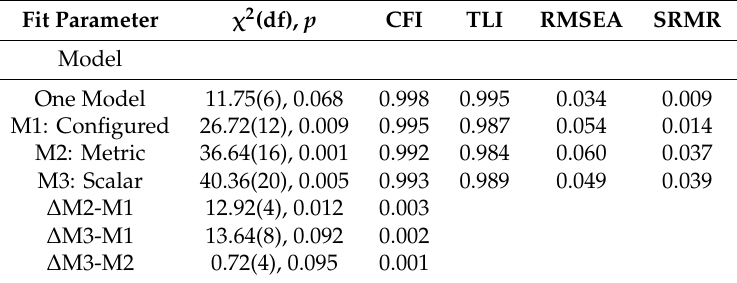
Table 3. Multiple group comparison for latent factors.